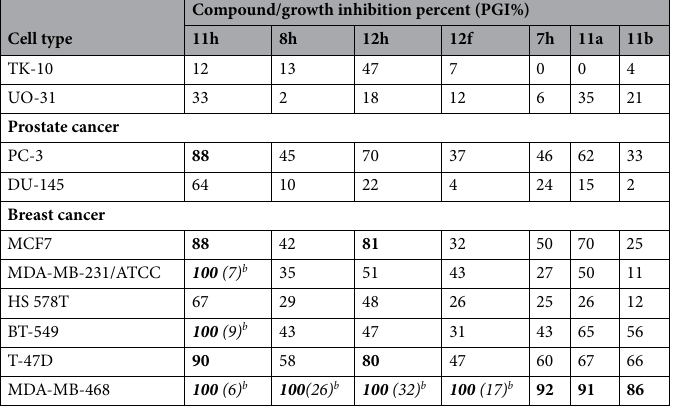
Table 3. Results of the in vitro NCI 60 human cancer cell lines single-dose assay for the most active hybrid quinoline–imidazole/benzimidazole compounds ( 11h , 8h , 12h , 12f , 7h , 11a and 11b ), expressed as percentage growth inhibition (PGI%, μM). The number reported for the one-dose assay, percentage growth inhibition (PGI), is growth relative to the no-drug control, and relative to the time zero number of cells; b Cytotoxic effect; lethality (L) percent is represented in brackets; the most active compounds are highlighted in bold and italics.